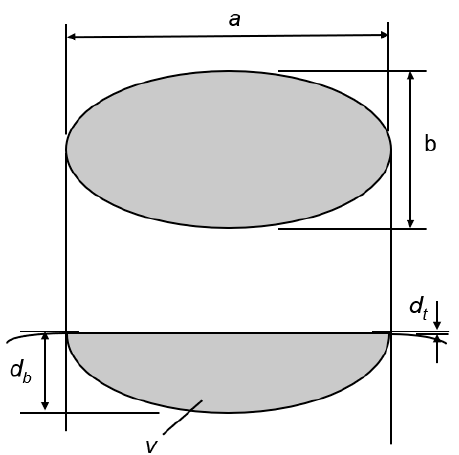
Figure 2. Determining bruise area and volume by using the elliptical method [10].